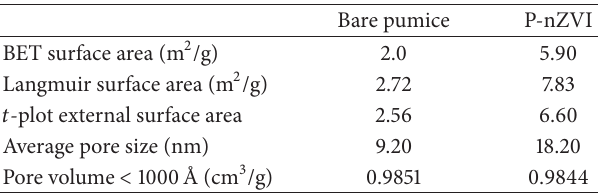
Table 2: BET analysis results of bare pumice and